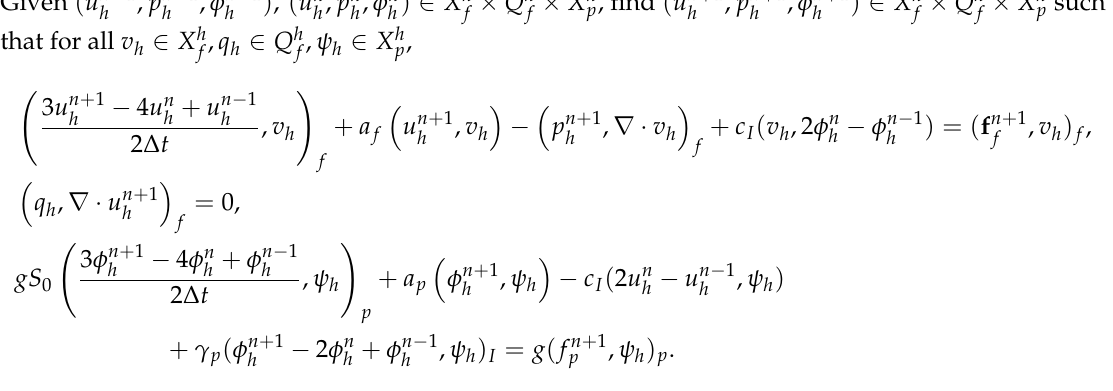
Algorithm 8 Second-order backward-differentiation